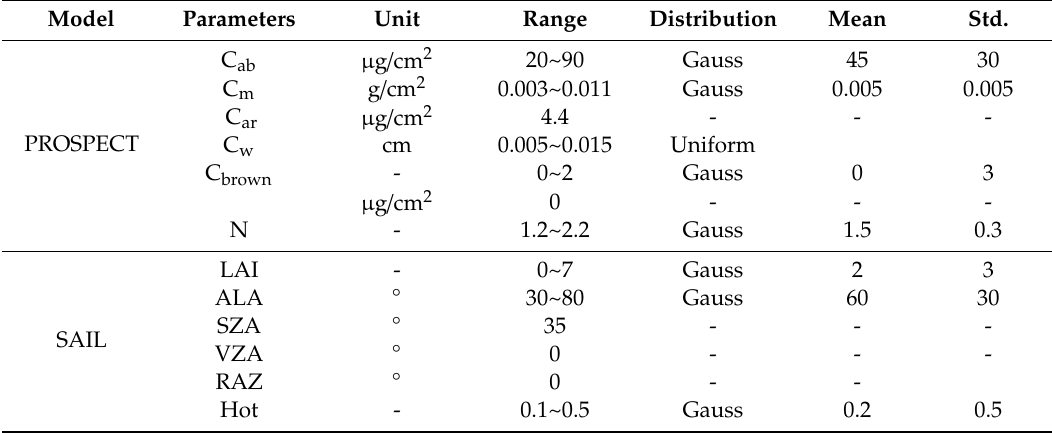
Table 4. The ranges or values given to the parameters for the PROSAIL